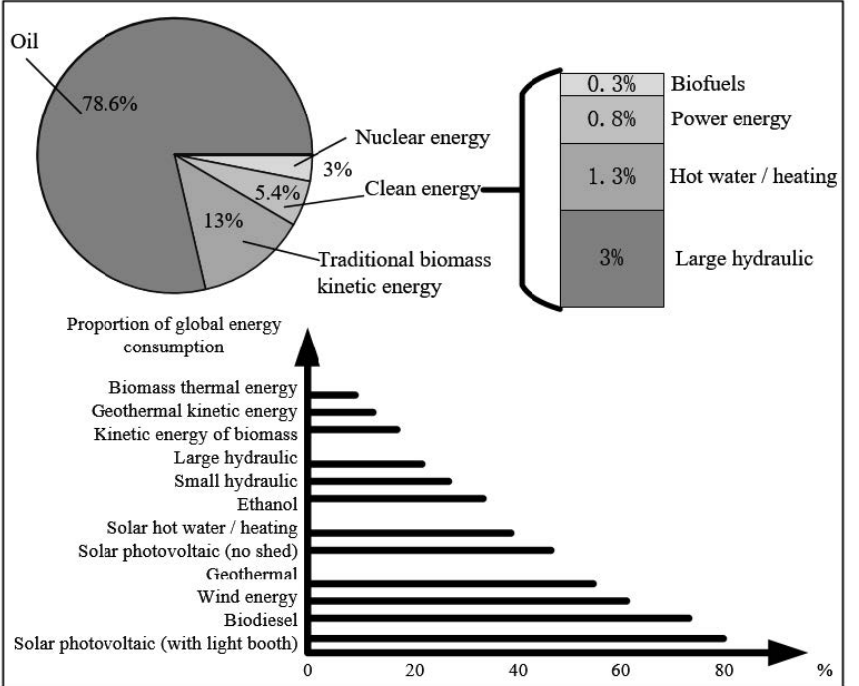
Fig. 1 Proportion of various types of global